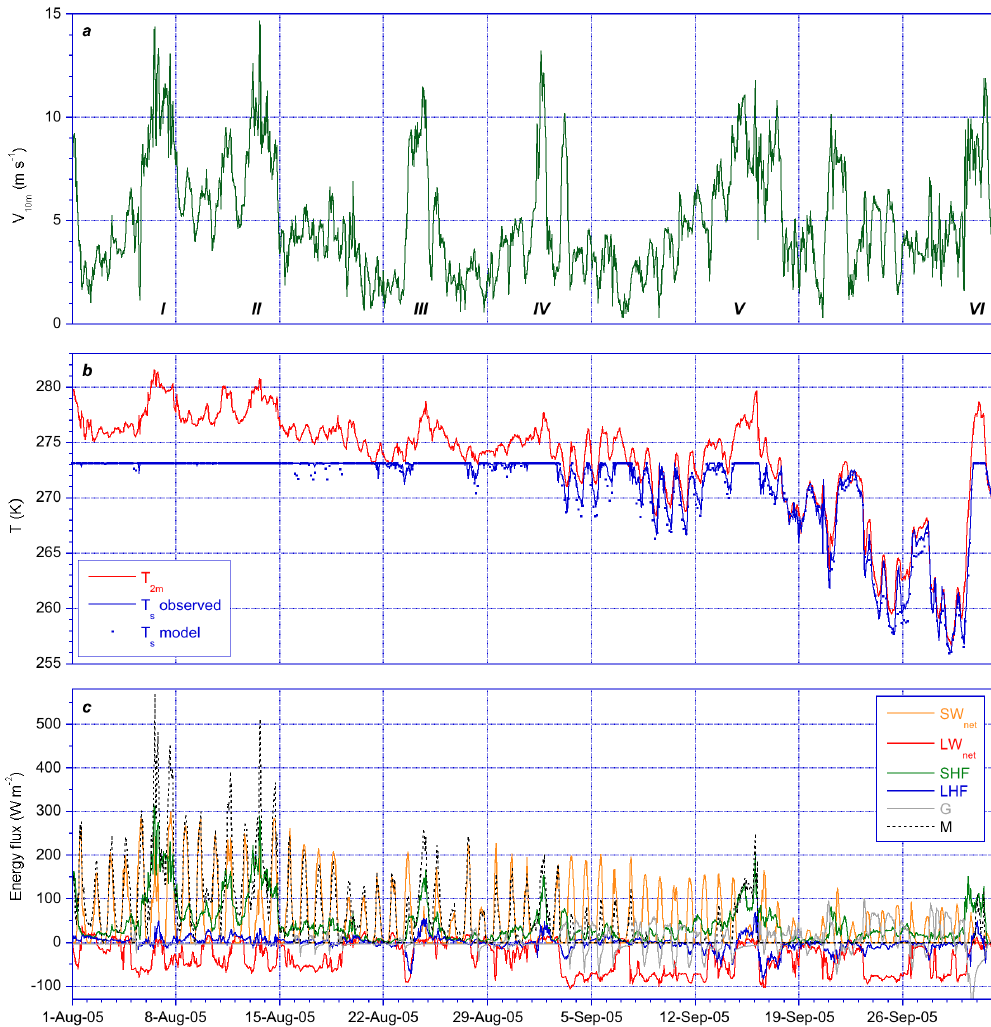
Fig. 12. Hourly averages at S5 for the period 1 August–30 September 2005 of (a) 10m wind speed, (b) 2m temperature and observed (lines) and modelled (dots) surface temperature T s , and (c) modelled surface energy balance